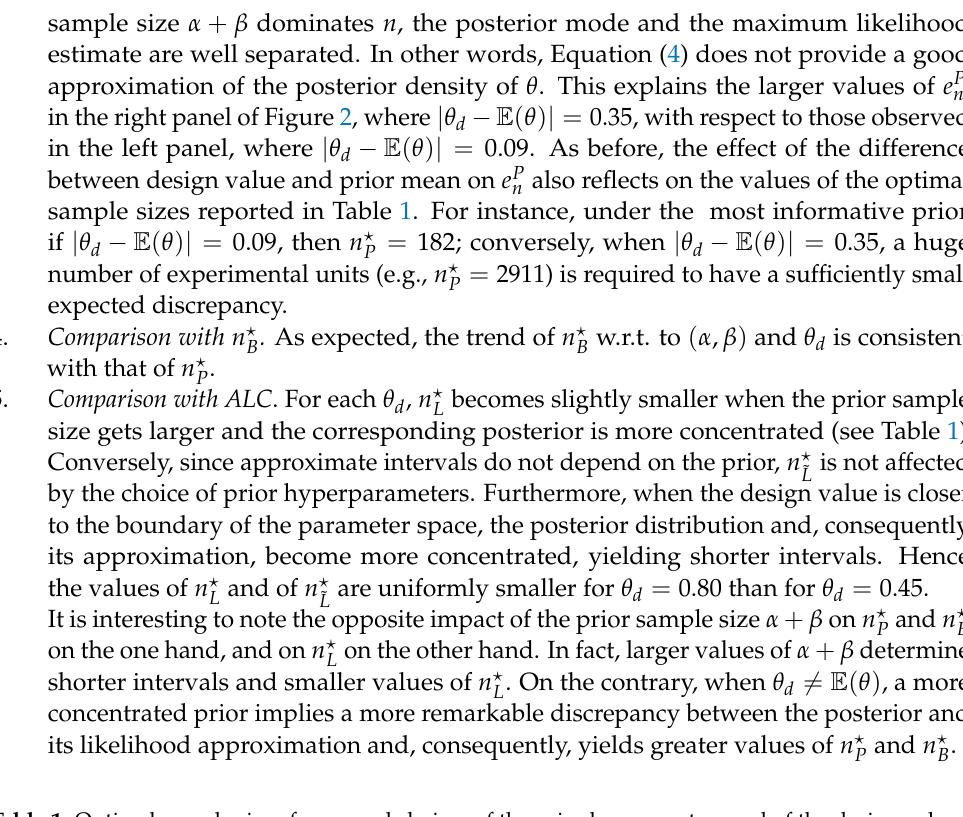
Table 1. Optimal sample sizes for several choices of the prior hyperameters and of the design values, given (cid:101) P = (cid:101) B = 0.01 and (cid:101) L =